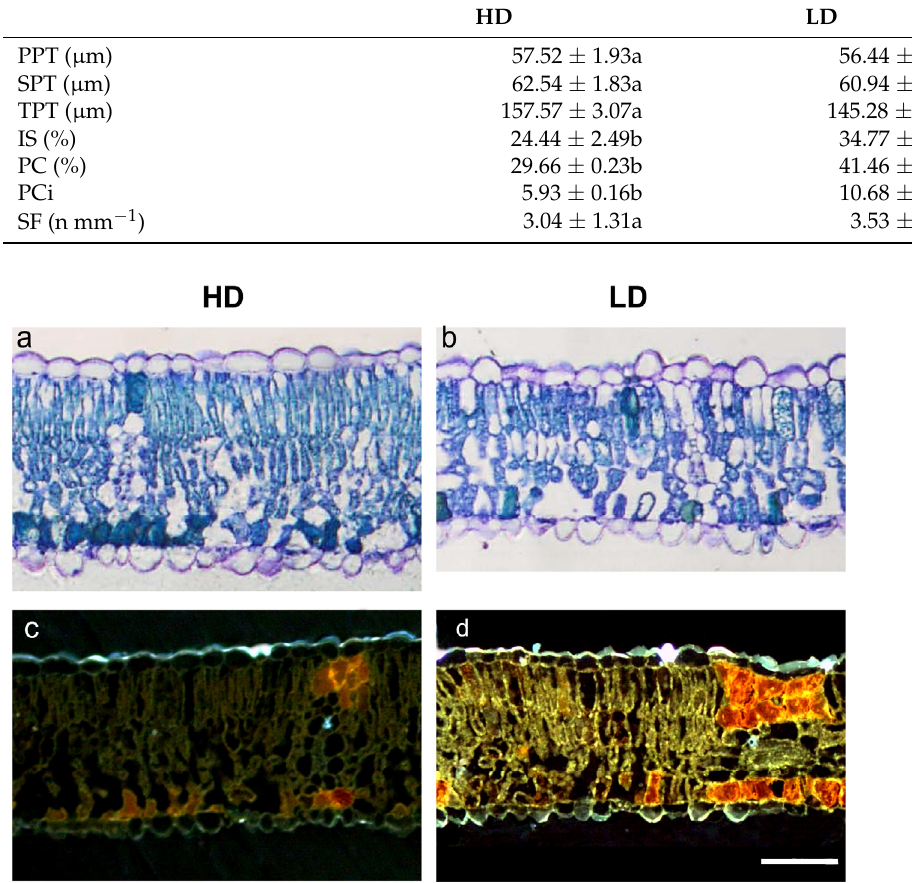
Table 2. Total parenchyma thickness (TPT), palisade parenchyma thickness (PPT), spongy parenchyma thickness (SPT), intercellular spaces (IS), percentage of tissue occupied by phenolic compounds (PC), phenolics content intensity (PCi), and stomata frequency (SF) in R. pseudoacacia HD and LD plants. Mean values and standard errors are shown. Different letters correspond to statistically significant differences ( p < 0.05) within each date of sampling.